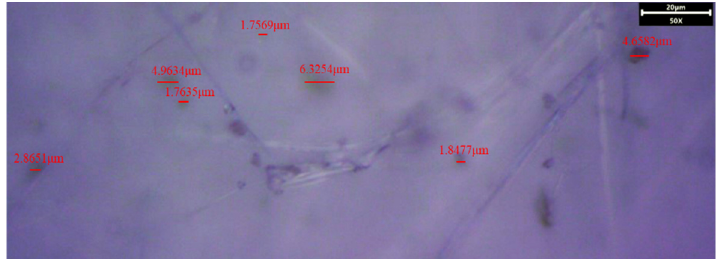
Figure 3. Sizes of different particles observed with a microscope at a magnification factor of 500.